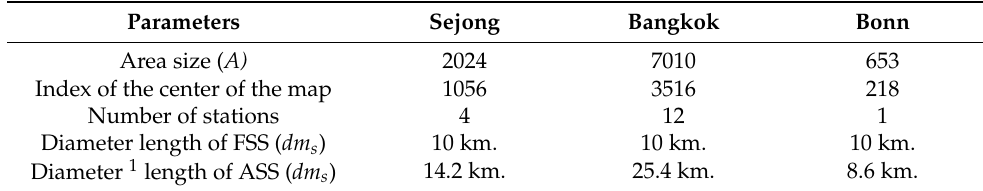
Table 2. Experiment Parameter